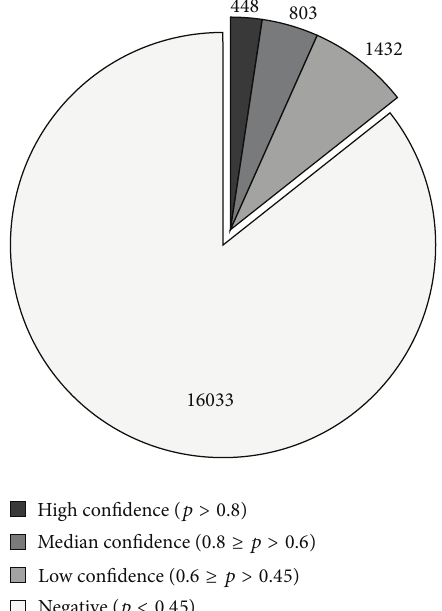
Figure 2: Number of predicted target genes in mouse genome. The predicted target genes were classified into 3 confidence levels according to the 𝑝 value computed in the logistic regression